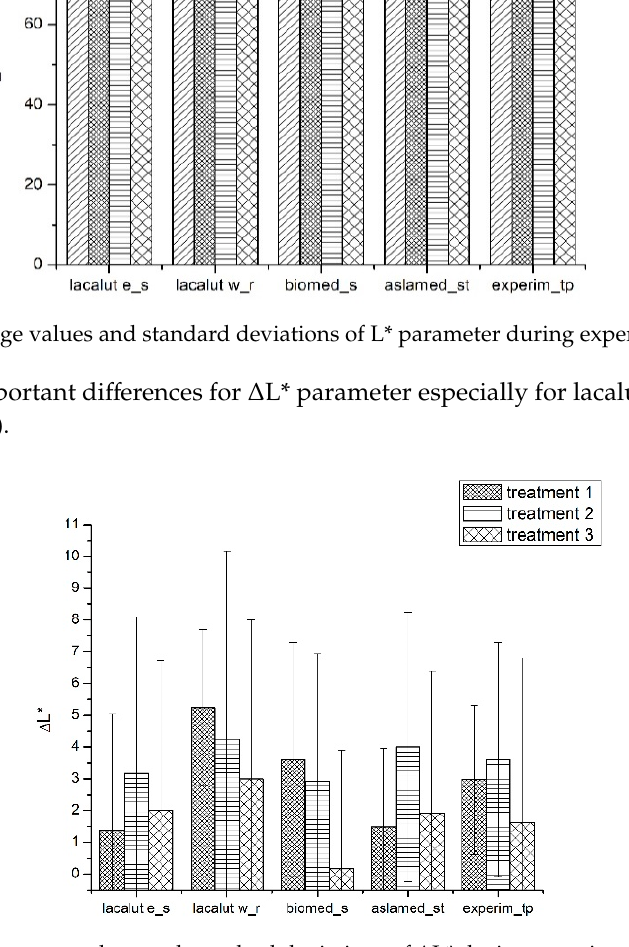
Figure 2. Average values and standard deviations of L* parameter during experimental phases.